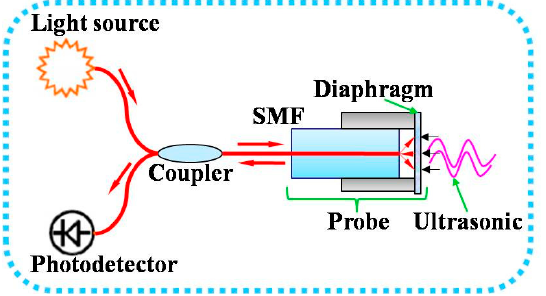
Figure 1. Schematic illustration of the fiber optic extrinsic Fabry–Perot interferometric (EFPI) ultrasonic sensor.